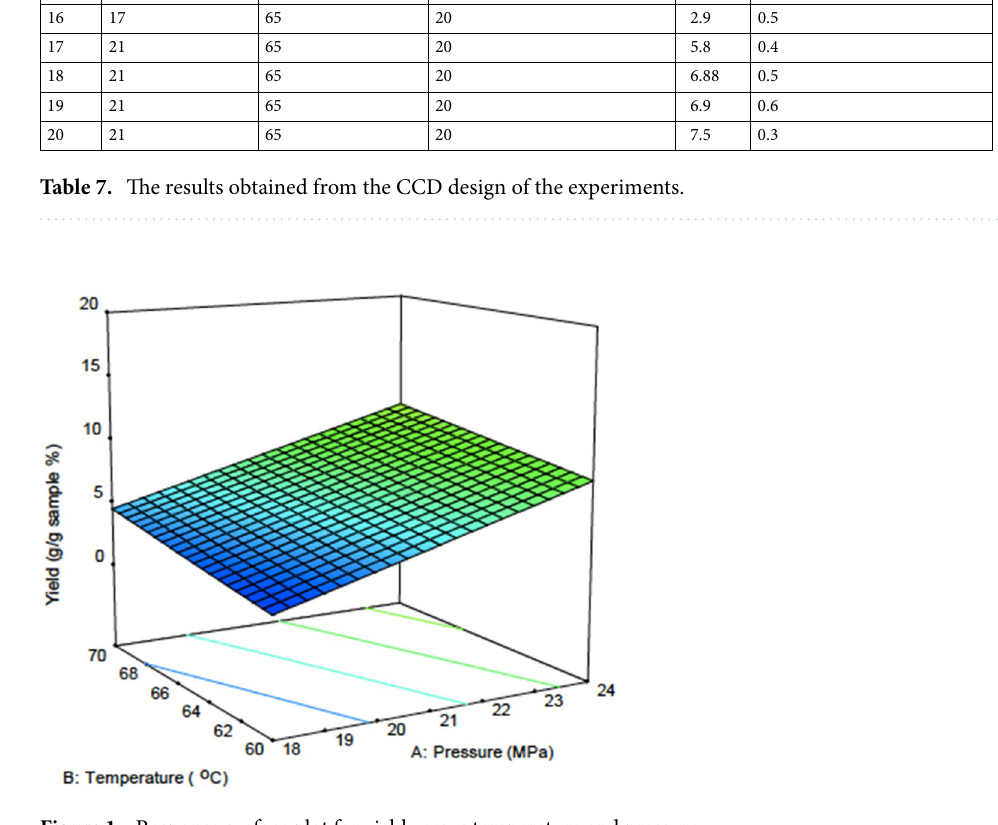
Figure 1. Response surface plot for yield versus temperature and